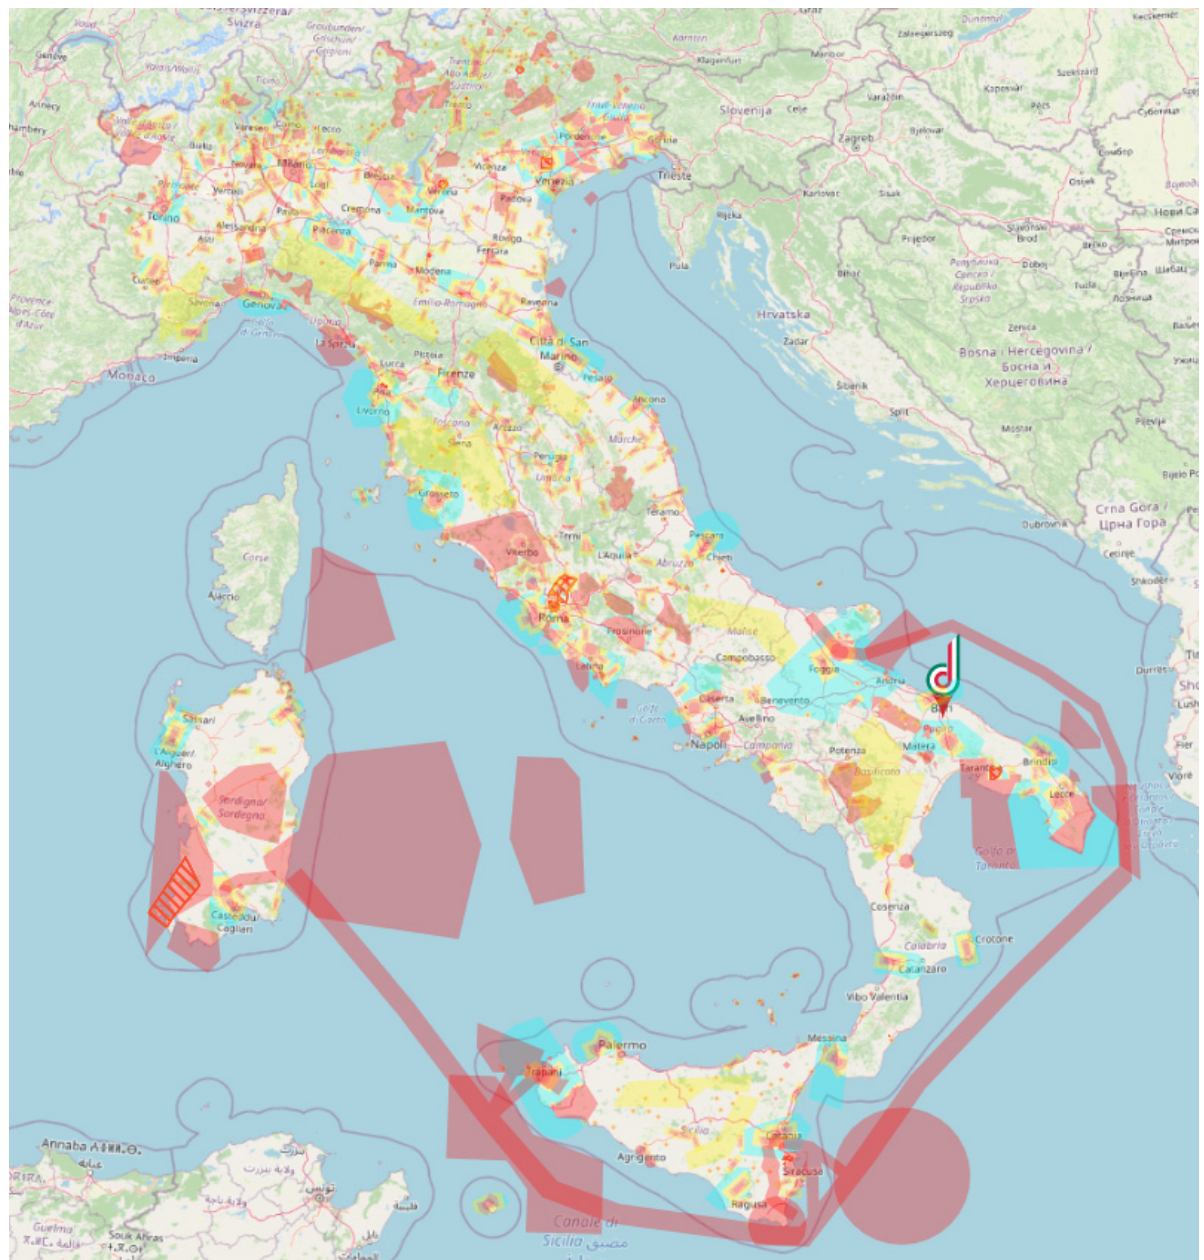
Figure 7. Italy map from the d-flight website. Red zones are prohibited. Icon “d” is the user position, when connected.